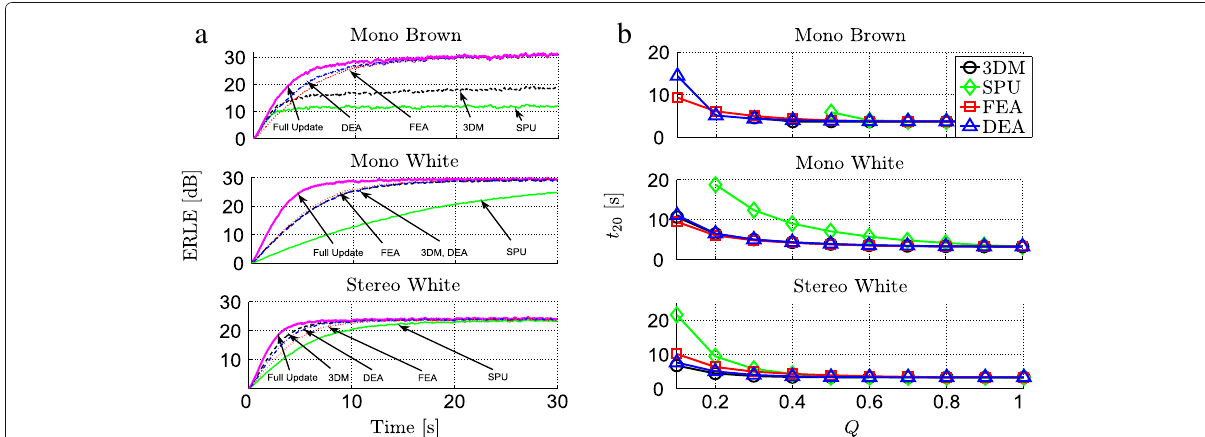
Fig. 10 ( a ) ERLE convergence curves for full filter update ( Q = 1) and for different tap selection schemes ( Q = 0.2), and ( b ) t 20 values for different values of Q (for mono brown, mono white, and stereo white noise signals)